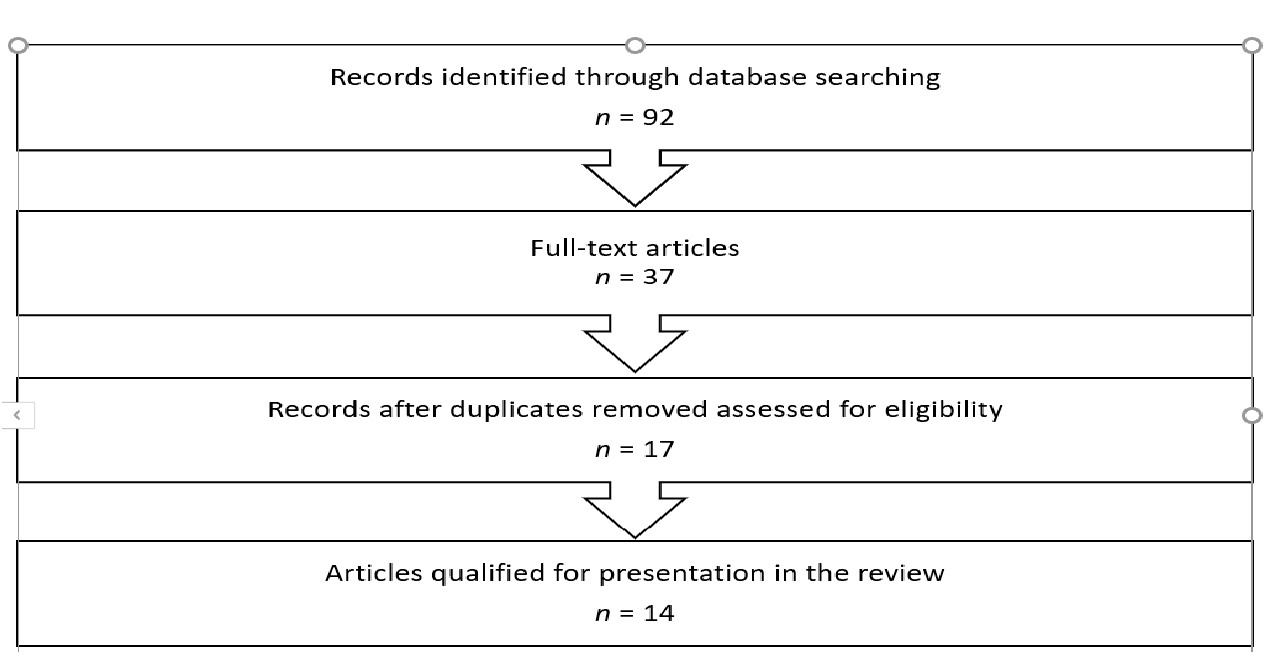
Figure 1. Literature selection process. Table 1. Systematics of reports cited in the review.